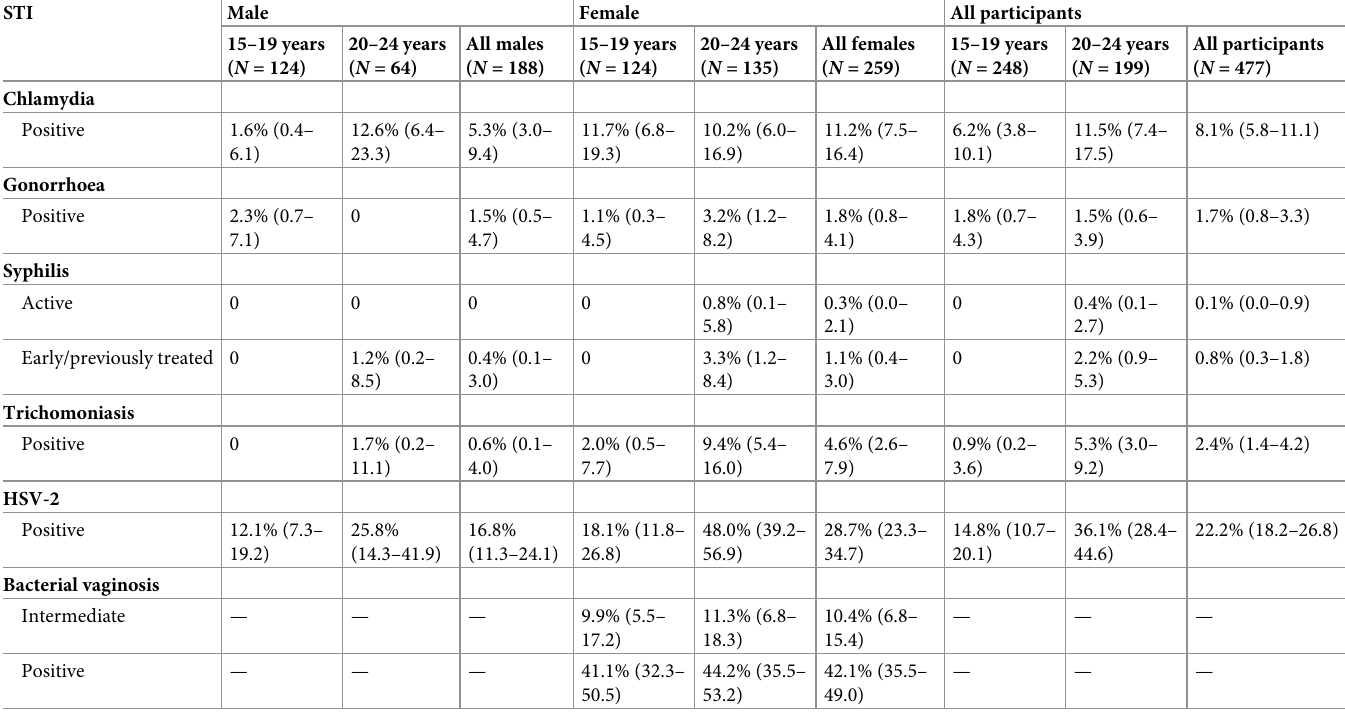
Table 2. Prevalence of STIs weighted for sampling and non-response in a population-based STI survey among young people aged 15–24 years in rural KwaZulu- Natal ( N = 447).